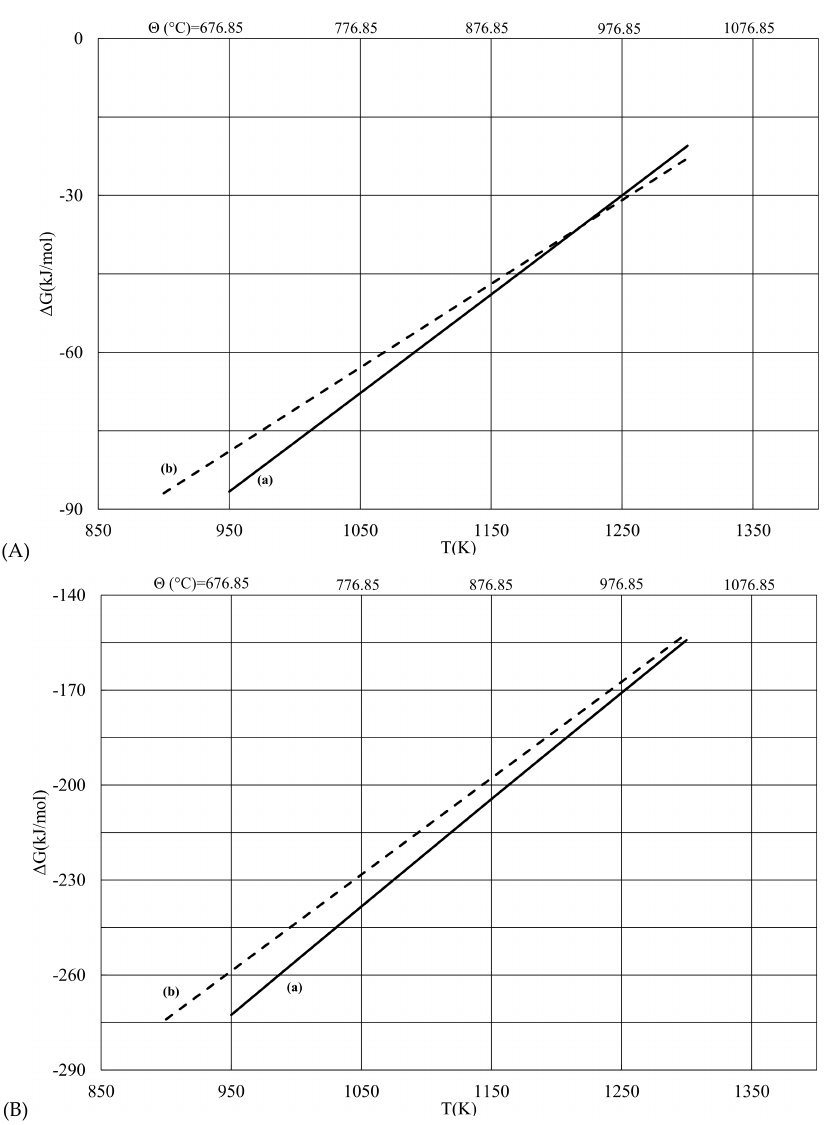
Table 2. Comparison between Δ G f values of (a) this study and (b) [25] for the reaction: 3Rh(s) + 2S 2 (g) = Rh 3 S 4 (s).